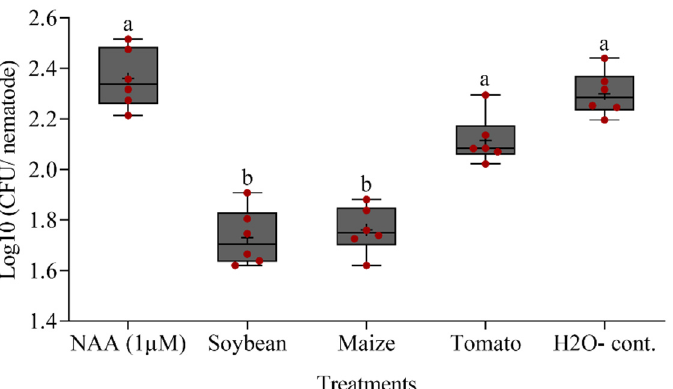
Figure 9. Effect of pre-incubation of P. penetrans in the root exudates of soybean, maize, or tomato on the attachment of the bacterial strain Microbacterium sp. i.14 to the surface of P. penetrans . Auxin (NAA) and sterile water were used as controls. Letters indicate significant differences among treatments (Tukey test, p < 0.05, n = 6). Medians are shown as (—), whiskers indicate quartiles.